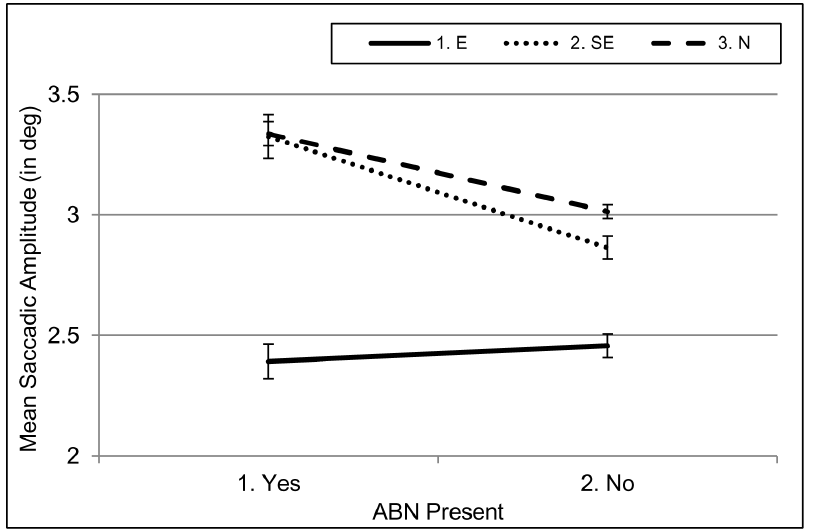
Figure 9. Interaction between Expertise and ABN for saccadic amplitude in ABN videos. Unlike experts, both semi-experts and naı¨ve participants reverted to clearly longer saccadic amplitudes in video sections where abnormalities were present.